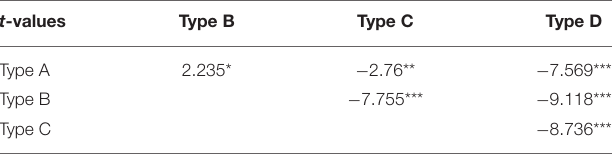
TABLE 3 | Results of paired sample t -test on searching time.